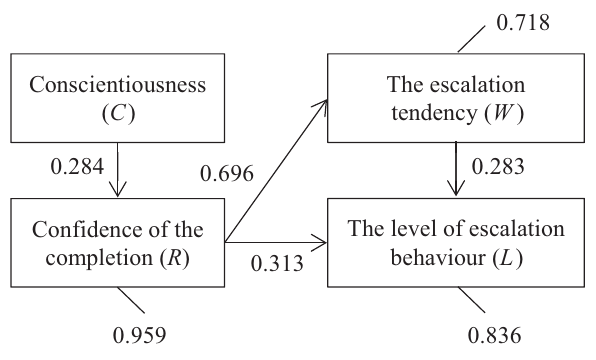
Figure 2. EOC model in Scenario